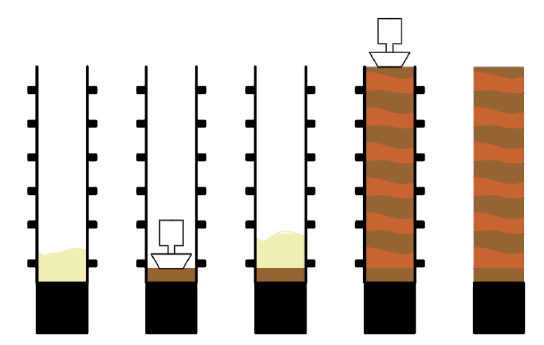
Figure 3. The rammed earth.